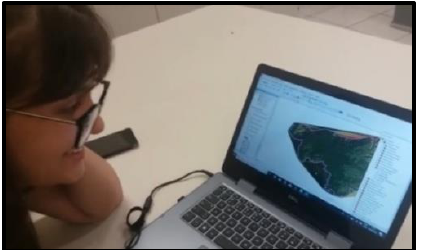
Figure 8. Story Map - We are all Refugees: the story of Brumadinho.